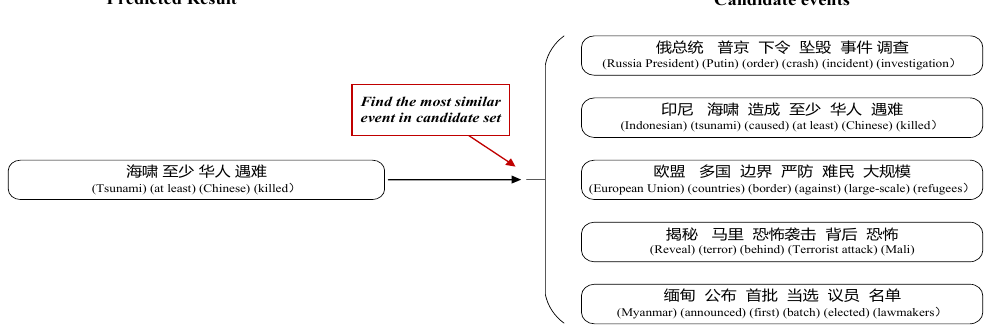
Figure 5. Event selection example. It verifies whether the model can find the correct event in the candidate set by the prediction result.